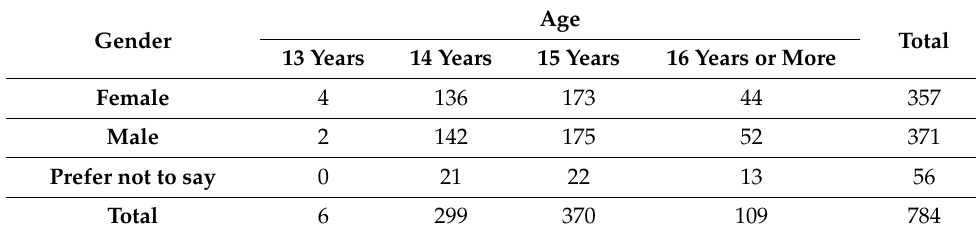
Table 1. Students participating in the research.